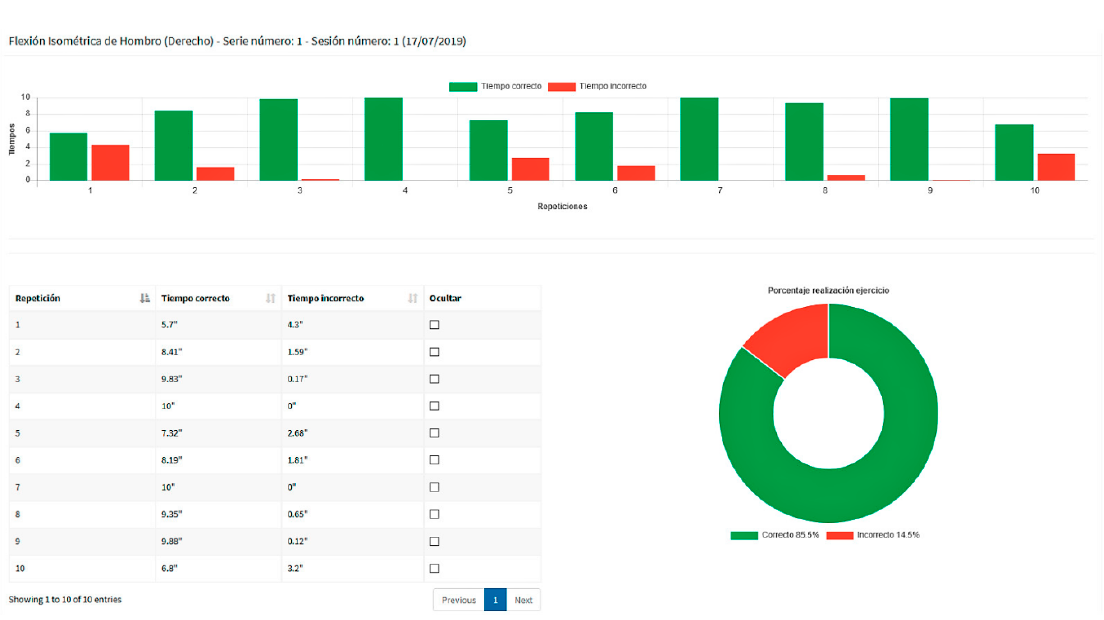
Figure 6. A report of a series of 10 repetitions of an isometric exercise.